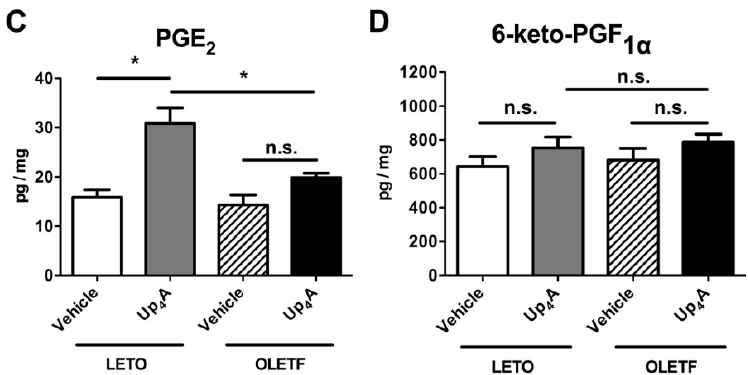
Figure 4. Release of the prostanoids prostaglandin (PG)F 2 α ( A ), thromboxane (Tx)B 2 (a stable metabolite of TxA 2 ) ( B ), PGE 2 ( C ), and 6-keto-PGF 1 α (a stable metabolite of PGI 2 ) ( D ), evoked by uridine adenosine tetraphosphate (Up 4 A; 3 × 10 − 5 mol/L) or vehicle (water) in aortic rings obtained from LETO ( n = 7) and OLETF ( n = 7) rats. The y -axis shows amounts of prostanoids expressed as pg/mg wet weight of aortic ring. Each column represents means ± standard error. * p < 0.05 vs. Up 4 A LETO. LETO, Long-Evans Tokushima Otsuka rats; OLETF, Otsuka Long-Evans Tokushima Fatty rats; n.s., not significant.